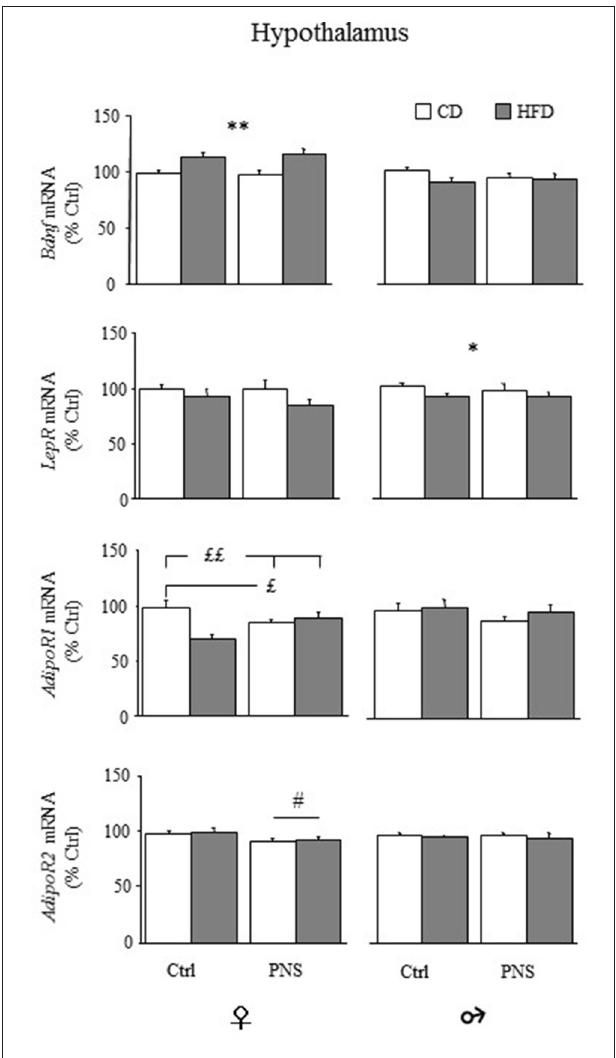
FIGURE 7 | Relative mRNA levels (% ctrl) of hypothalamic Bdnf, leptin ( LepR ) and adiponectin receptors ( AdipoR1 and AdipoR2 ). Total Bdnf mRNA levels were increased only in females as a result of HFD feeding (HFD vs. CD). LepR mRNA levels were reduced only in male rats following HFD (HFD vs. CD). AdipoR1 mRNA was reduced both in Ctrl-HFD as well as in PNS-CD females while PNS-HFD subjects showed AdipoR1 levels comparable to those observed in Ctrl-CD rats (Ctrl-HFD vs. Ctrl-CD and PNS-HFD; PNS-CD vs. Ctrl-CD). AdipoR2 levels were increased only in females as a result of HFD feeding (HFD vs. CD). Data are shown as mean + SEM. * p < 0.05, ** p < 0.01 main effect of Diet; £ p < 0.05, ££ p < 0.01, interaction between